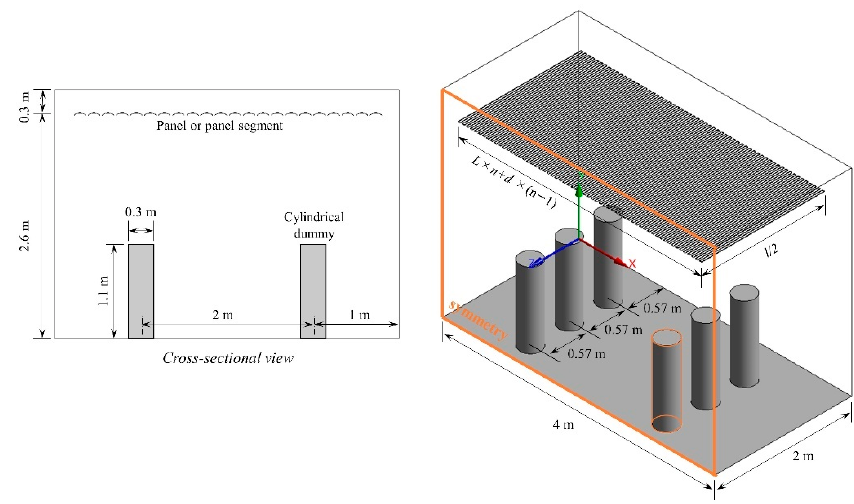
Figure 2. The geometry of the model and a cross-sectional view at the middle plane.